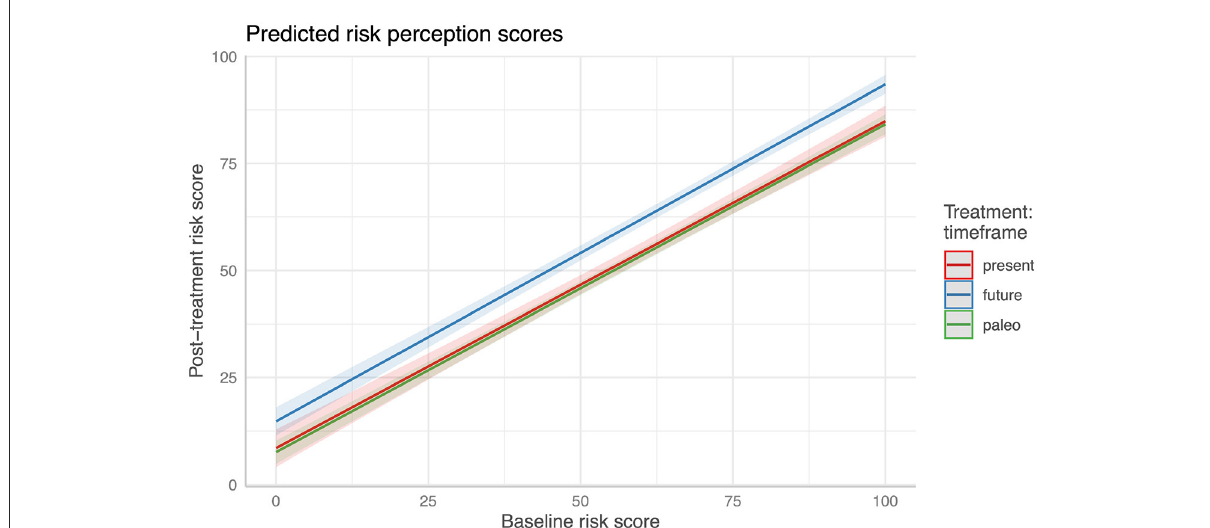
FIGURE2 Plot of predicted post-treatment risk perception scores by pretreatment risk perceptions and assigned infographic treatments.